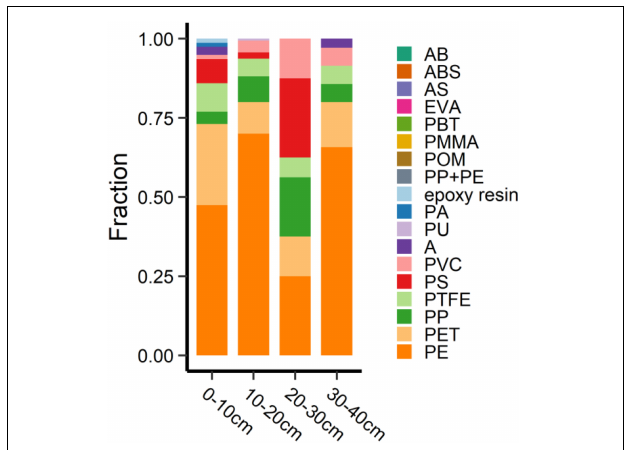
FIGURE 6 | Depth-dependent percentage of different MPs at the Yangjiang beach. Abbreviations for the MPs: PE, polyethylene; PS, polystyrene; PVC, polyvinyl chloride; PP, polypropylene; PP + PE, the mixture of PP + PE; PA, polyamide; ABS, the copolymer of acrylonitrile-butadiene-styrene; POM, polyoxymethylene; PET, polyethylene terephthalate; PU, polyurethane; AB, the copolymer of acrylonitrile-butadiene; PTFE, polytetrafluoroethylene; AS,